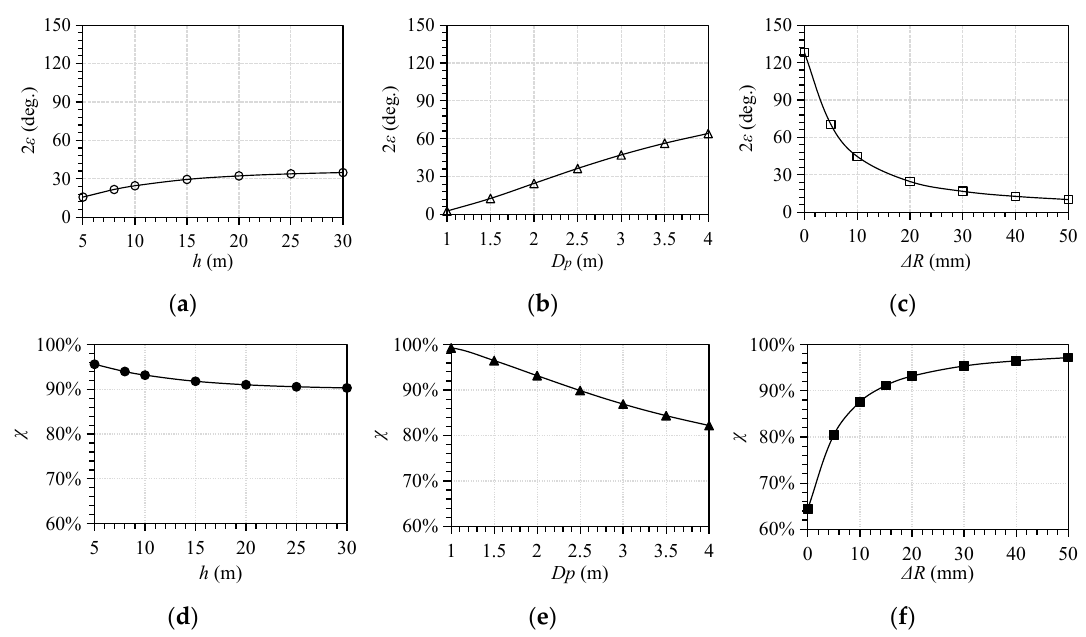
Figure 10. The influences of factors of h , D p , and Δ R on the pipe-soil contact angle 2 ε ( a – c ) and lubrication efficiency χ ( d – f ) .